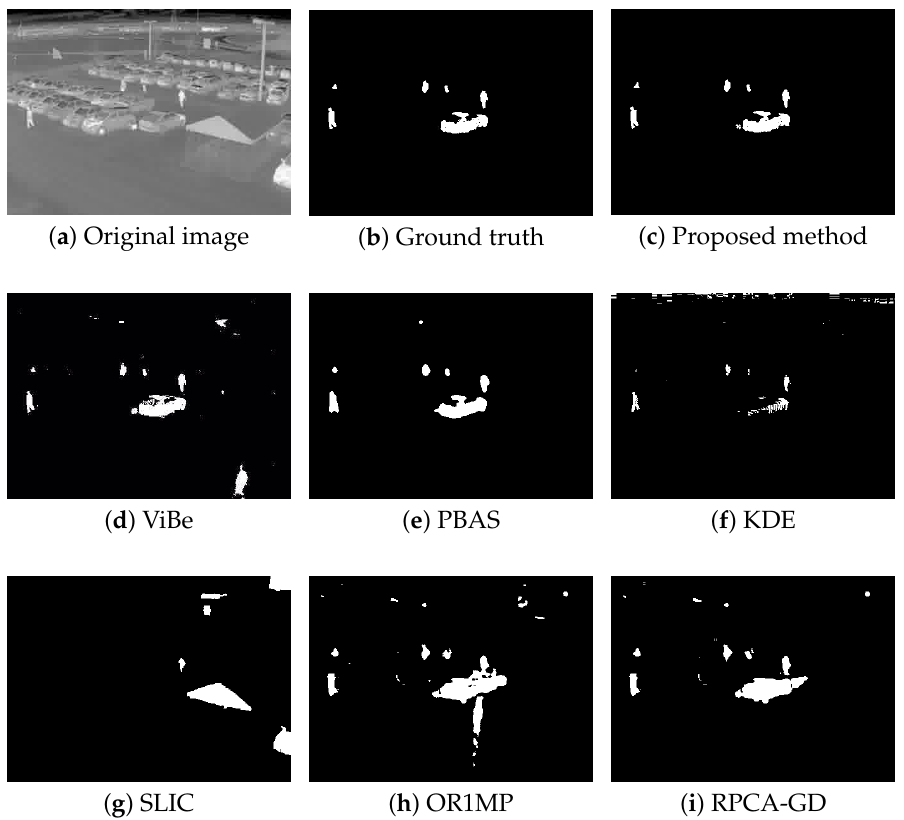
Figure 6. The detection results of the 173th frame in Seq.